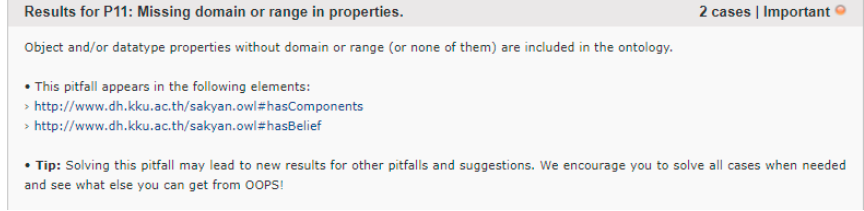
Figure 8. An excerpt from the important pitfall.